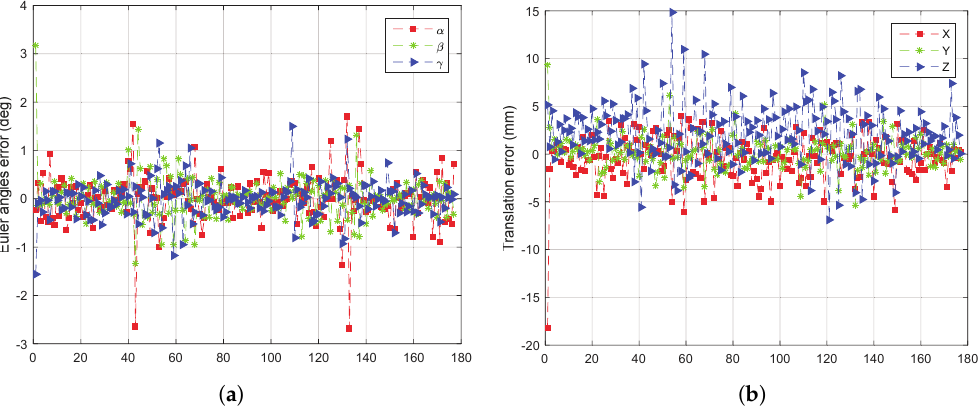
Figure 11. The error curve of ( a ) rotation and ( b ) translation of test